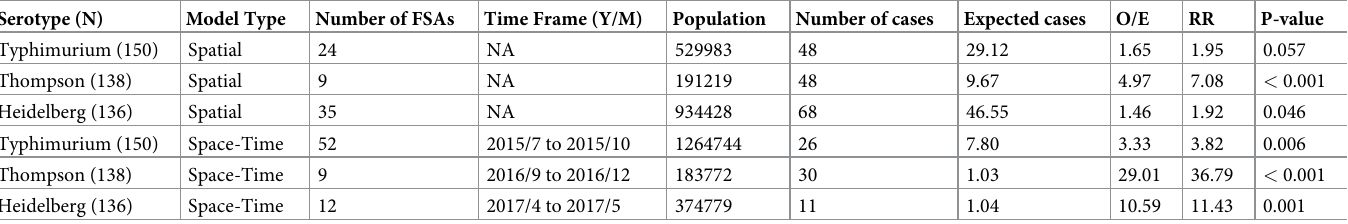
Table 1. Spatial and space-time clusters of nontyphoidal Salmonella enterica infections with major serotypes in the city of Toronto, Ontario, Canada, 2015–2017 1 . Serotype